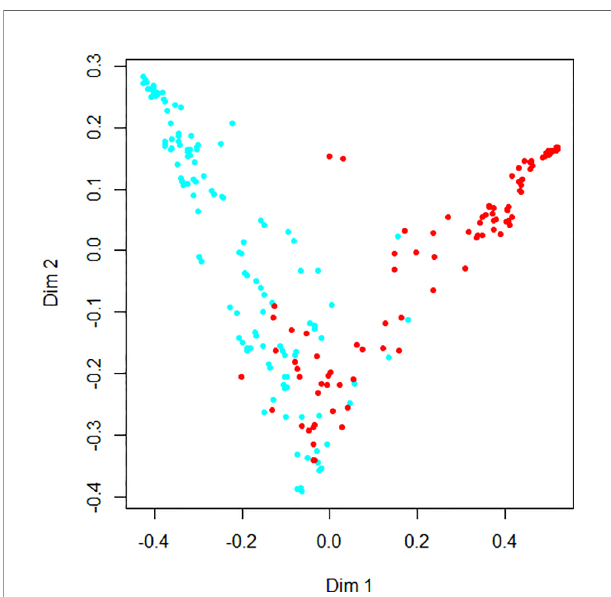
FIGURE 4 | The random forest map for diabetic retinopathy detection.